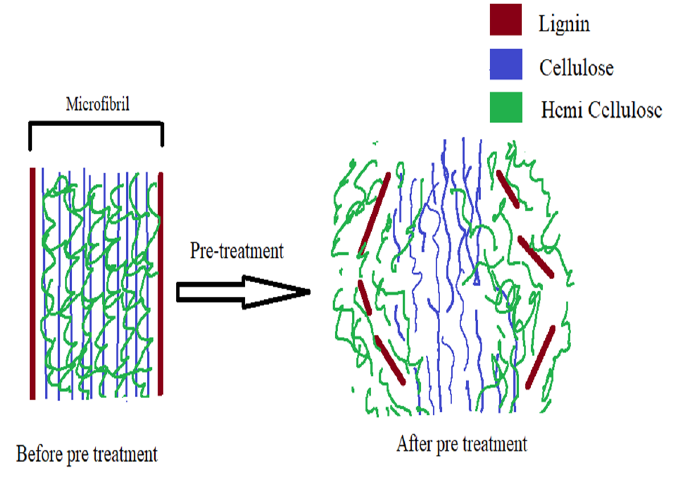
Figure 4. Significance of pre-treatment of lignocellulose.